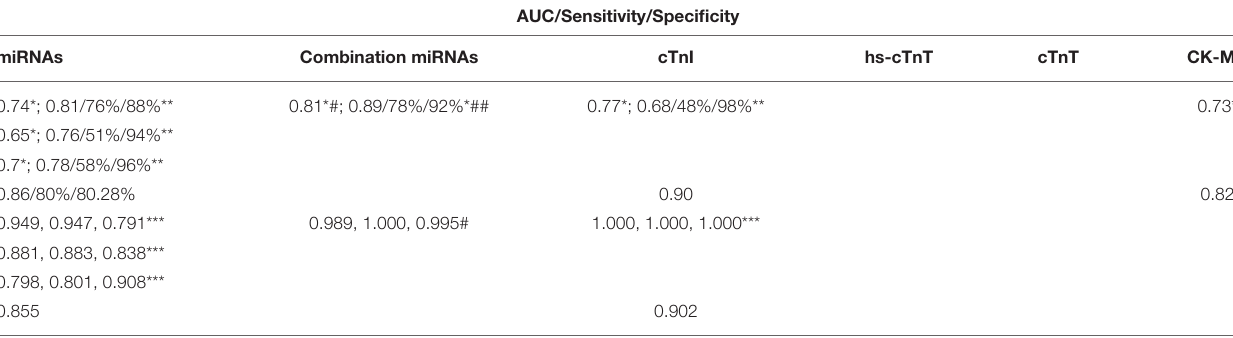
TABLE 3B | Peak hour and AUC comparison of miRNAs and conventional